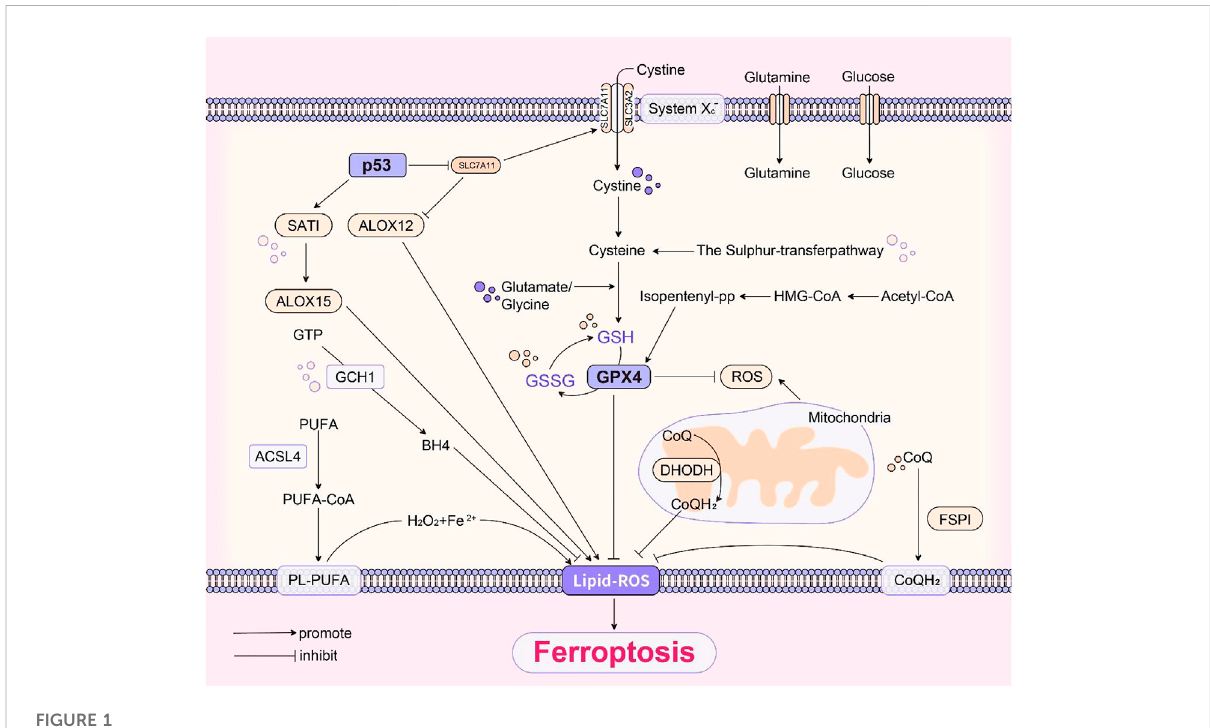
FIGURE 1 (The basic pathways of